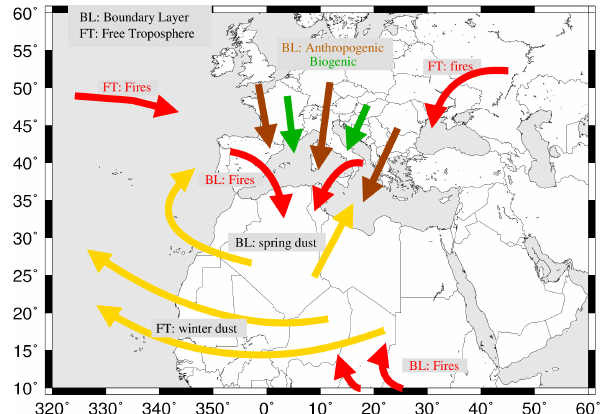
Figure 1. Synthesis of all aerosol types and transport pathways in the Mediterranean area. BL and FT stand for boundary layer and free troposphere,